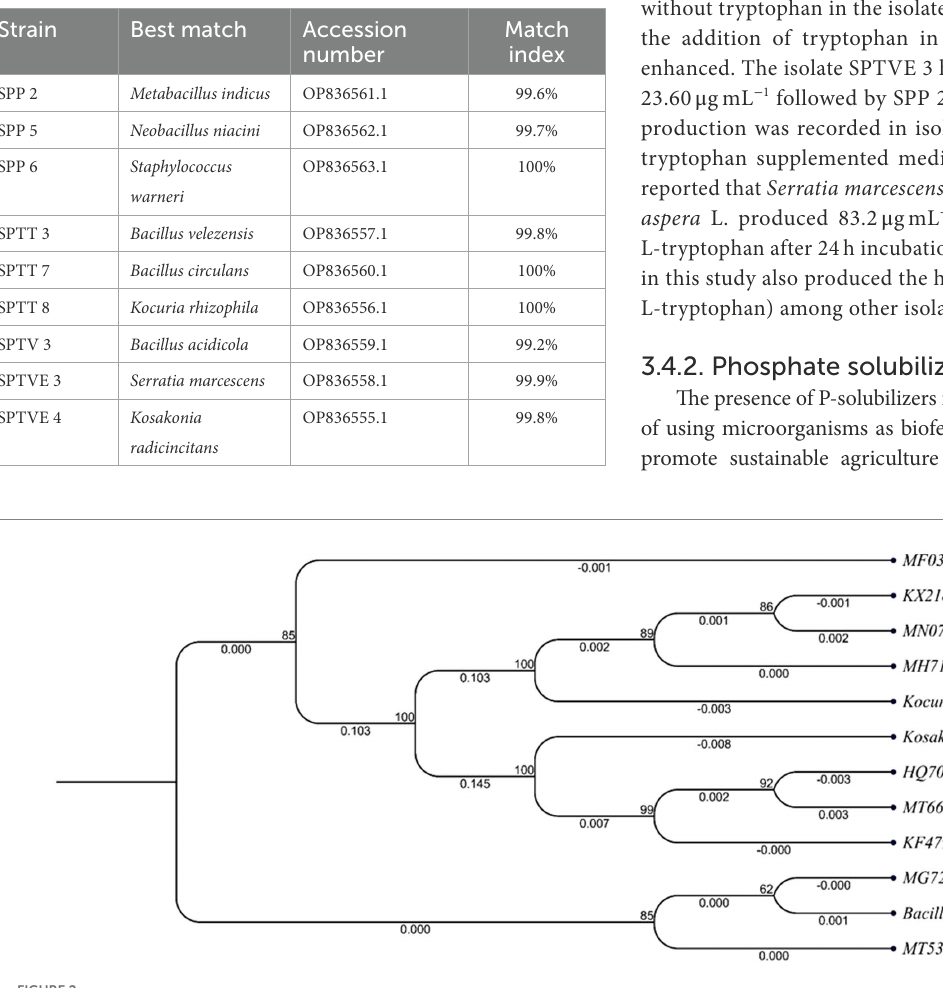
FIGURE 2 Phylogenetic tree of halotolerant isolates used for developing microbial consortium – II ( Bacillus velezensis ; Kocuria rhizophila and Kosakonia radicincitans ). The 16S rRNA gene sequences of closely related species were retrieved from NCBI GenBank databases. The Neighbor joining phylogenetic tree was inferred using MEGA-7 software; evolutionary distance was computed using Maximum Composite Likelihood method at bootstrap value of